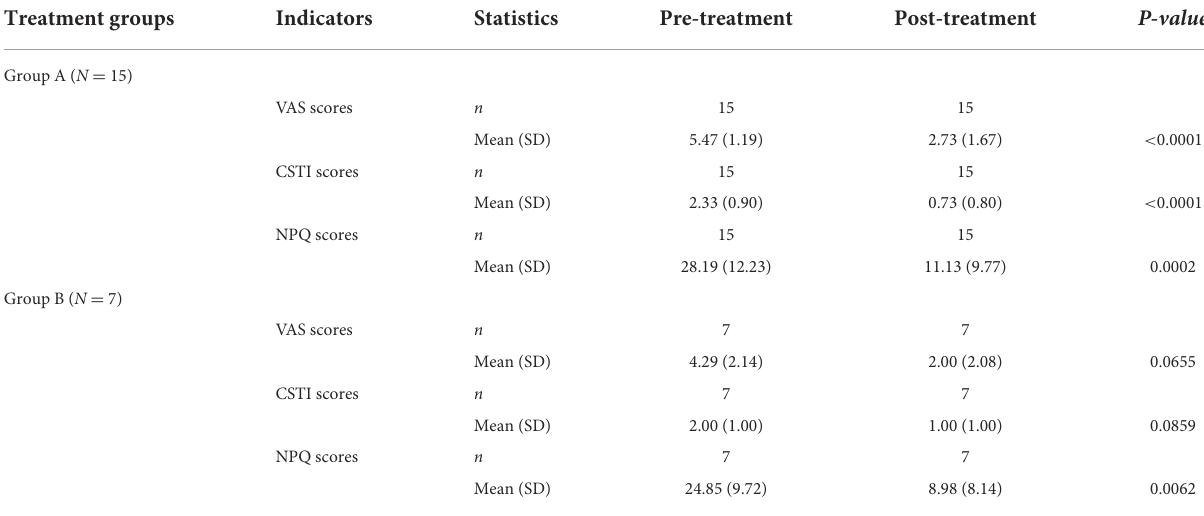
TABLE 9 Intragroup comparison of secondary indicators before and after treatment in patients with neck and shoulder pain. Treatment